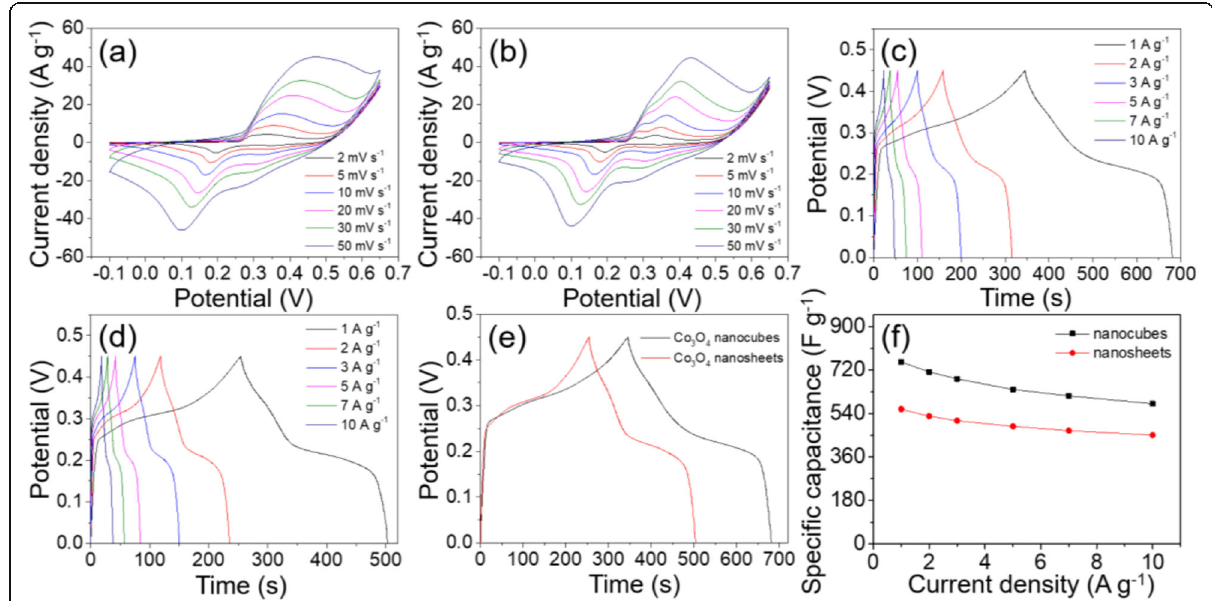
Fig. 6 CV curves measured with different scan rates for a porous Co 3 O 4 cubes and b porous Co 3 O 4 nanosheets, CP curves measured with different current densities for c porous Co 3 O 4 cubes and d porous Co 3 O 4 nanosheets, e CP curves of the two electrodes obtained at 1 A g − 1 , and f specific capacitances obtained at various current